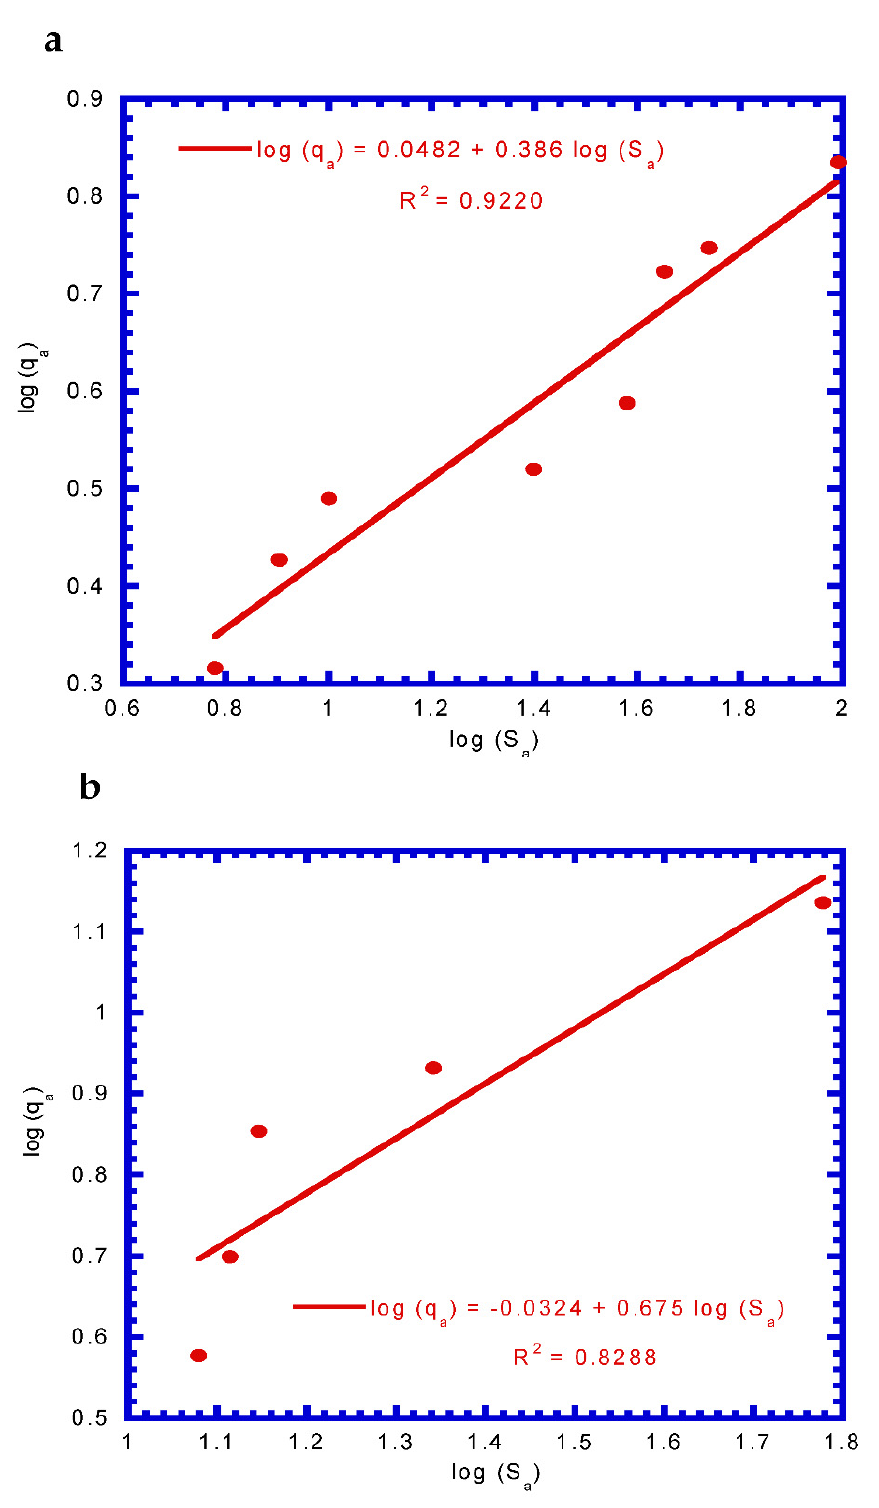
Figure 3. Freundlich isotherm for COD by granular activated carbon (GAC) adsorption to determine the coefficients ( K a and 1/n) at ( a ) 24 h and ( b ) 54 h.